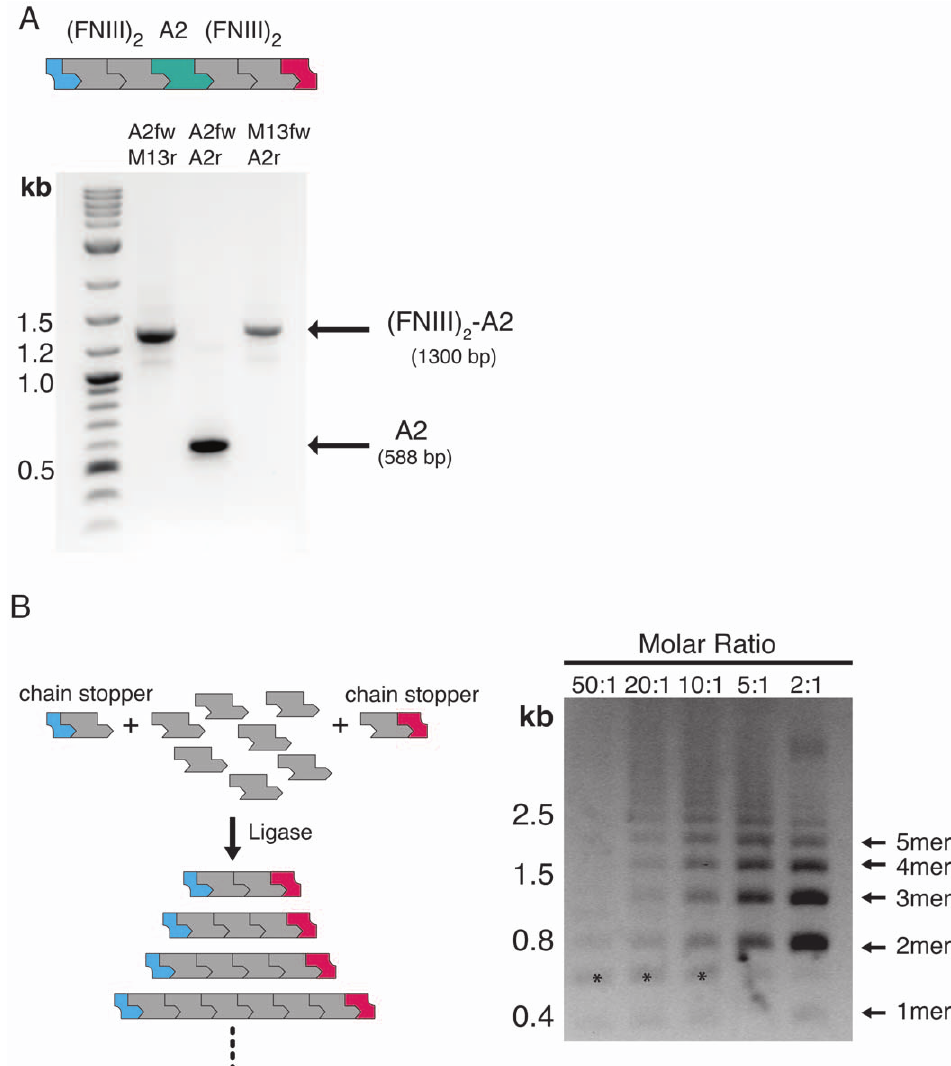
Figure 5. Assembly of chimeric constructs and one-pot concatamer formation. (A) Assembly of (FNIII) 2 -VWFA2-(FNIII) 2 sandwich constructs from a modular assembly vector (top). PCR amplification with specific primers (indicated above the lanes; Table S1 ) show that the A2 synthon is sandwiched between two 13 FNIII repeats. (B) One-pot concatamer formation with orthogonal chain stoppers. Fully deprotected synthons are mixed in different molar ratios with orthogonal chain stoppers (equivalent synthons with protecting groups on one end). Increasing the concentration of chain stoppers shifts the size distribution towards shorter concatamers. Molar ratios of unprotected synthons:chain stoppers are indicated at the top of the lanes. Bands marked with asterisks presumably correspond to circularized dimers.